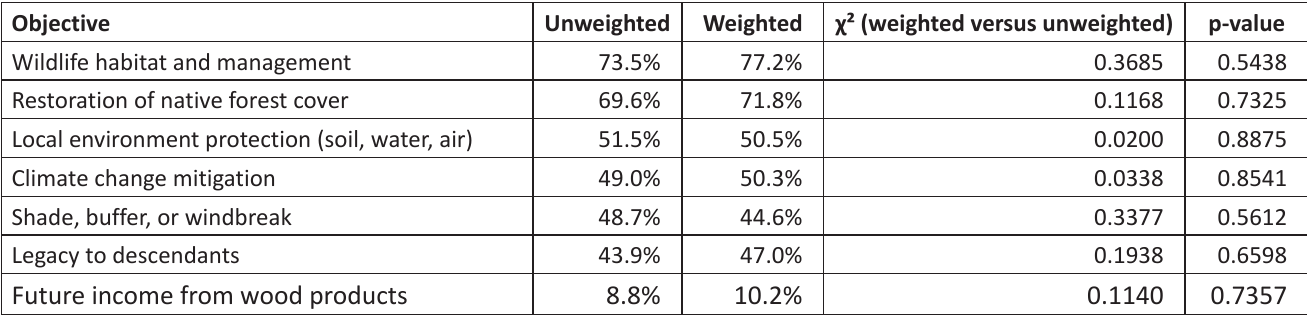
Table 2: Weighted and unweighted percent of respondents reporting each reason for planting trees, including χ² scores and